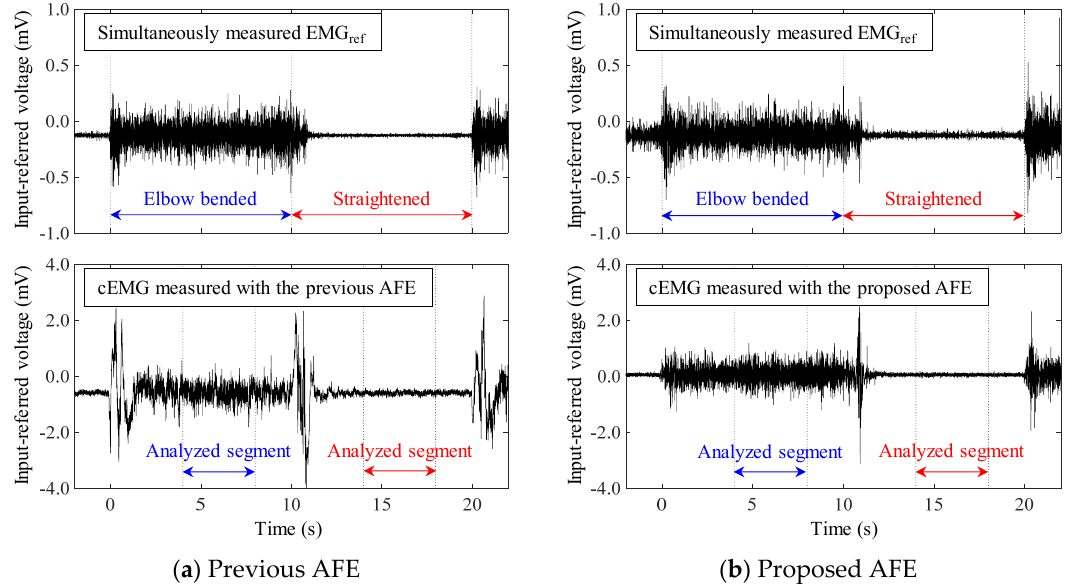
Figure 9. Examples of simultaneously measured reference EMG (EMG ref ) and cEMG through cotton cloth (0.26 mm thick) under conditions of low-humidity (19%, 3.91 g / m 3 ) from subject #E using ( a ) the previous AFE and ( b ) the proposed AFE.